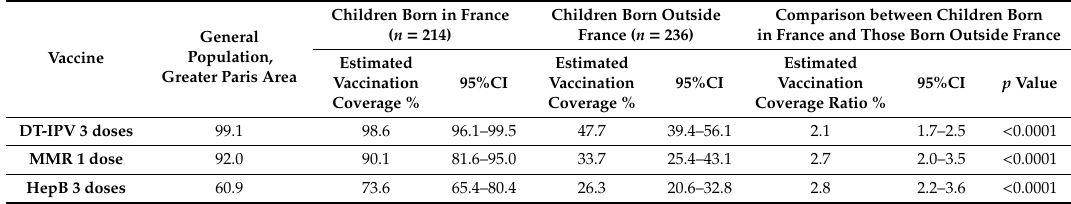
Table 2. Vaccination coverage at 24 months in the general population (Ile-de-France) and estimated vaccination coverage at 24 months in the children of homeless families (born in or outside France). Children Born in France Children Born Outside Comparison between Children Born ( n = 214) France ( n = 236) in France and Those Born Outside France General Population, Vaccine Estimated Estimated Estimated Greater Paris Area Vaccination 95%CI Vaccination 95%CI Vaccination 95%CI p Value Coverage % Coverage % Coverage Ratio % DT-IPV 3 doses 99.1 98.6 60.9 <